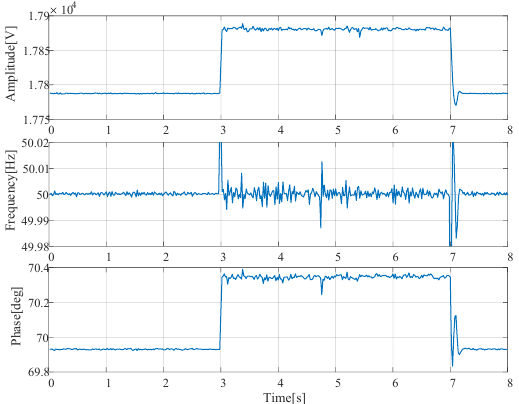
Figure 16. Measurement results of the PMU prototype under load switching.